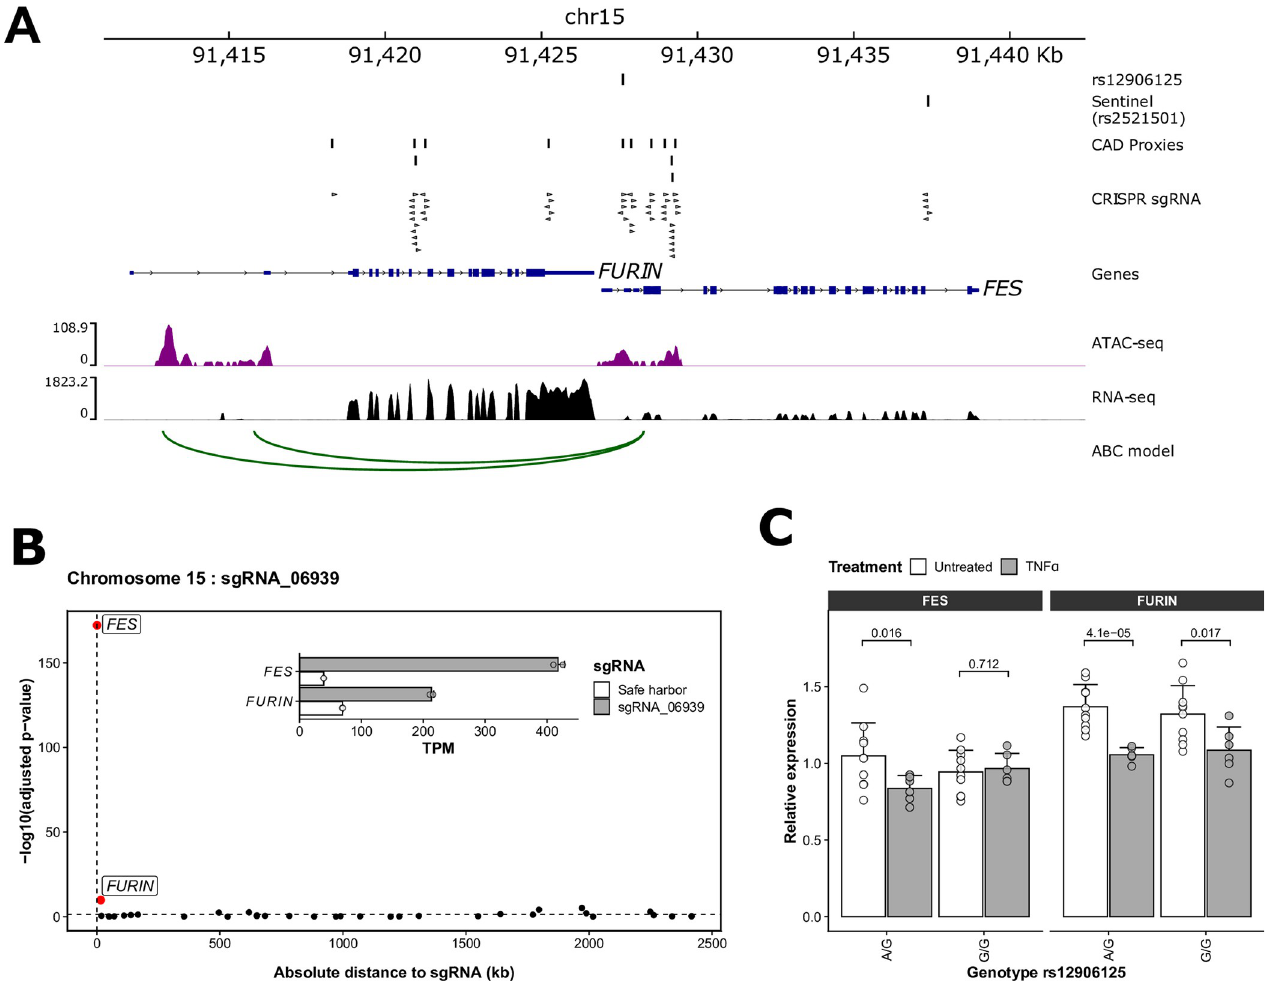
Fig 4. Characterization of a CAD-associated regulatory variant located within an enhancer at the FURIN / FES locus. ( A ) CRISPRa perturbations highlighted rs12906125 as a potential regulatory variant for FURIN and FES . The variant overlaps an ATAC-seq peak in the promoter of FES and a H3K27ac- defined enhancer that physically interacts with the FURIN promoter through chromosomal loops predicted by the ABC model applied to teloHAEC Hi-C data [7,33].( B ) Within a 2.5-Mb window, FES and FURIN are the top two differentially expressed genes when targeting rs12906125 by CRISPRa in teloHAEC. The inset plot shows the induction of both FES and FURIN expression with sgRNA_06939 when compared to the control safe harbor sgRNA. ( C ) teloHAEC are heterozygous (A/G) at rs12906125. We used base editing to change the genotype at rs12906125 to G/G. There was no significant difference in expression for FES and FURIN when comparing unstimulated teloHAEC with the A/G and G/G genotypes. However, upon activation with TNF α , we found that the reduction in FURIN levels was independent from the rs12906125 genotype whereas for FES , the reduction was genotype-dependent. Numbers above the bars are Student’s t -test P -values. We tested at least six clones of each